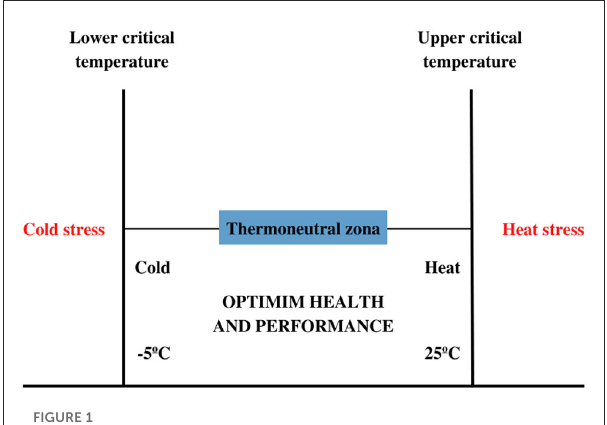
FIGURE1 Critical temperatures and thermo-neutral zone in dairy cattle. Adapted from Avendaño-Reyes